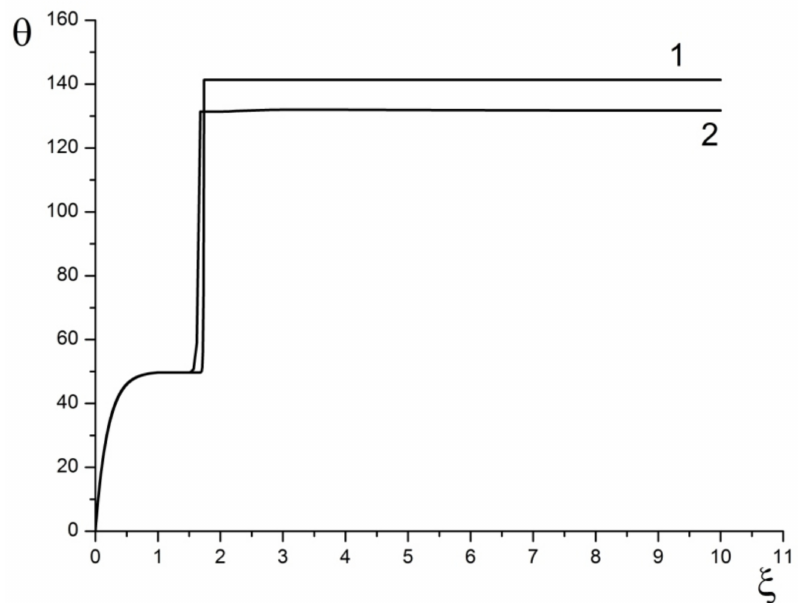
Figure 3. Monotonic solutions. 1—approximate model (29); 2—original model (5); Pe = 135; A = 2.75 × 10 − 18 ; Ar = 0.012; h s = 7.14 × 10 2 ; θ s = 50; g = 1.0 × 10 − 20 ; µ = 91.67; ξ 0 =